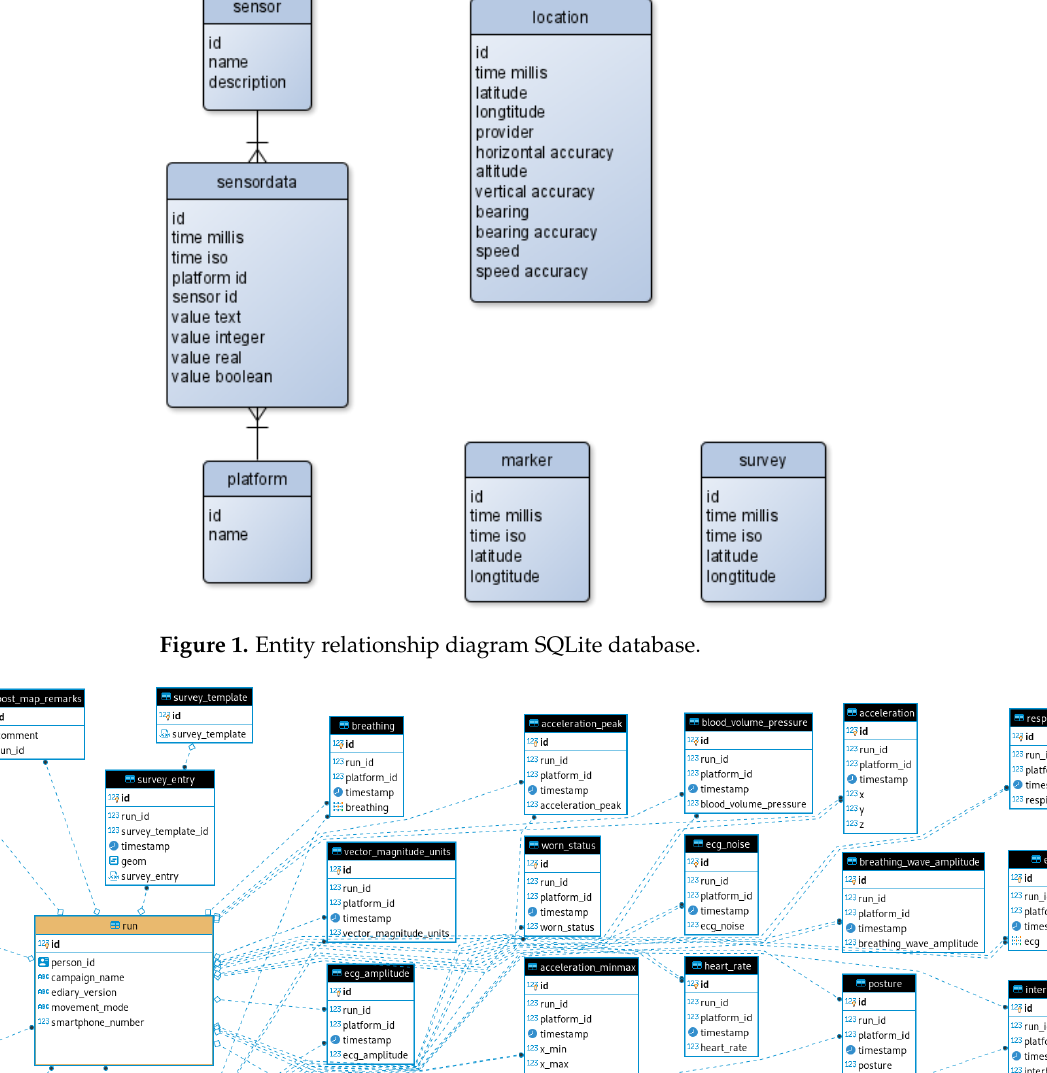
Figure 2. PostgreSQL database schema designed to hold data from multiple measurement campaigns, users and sensors.